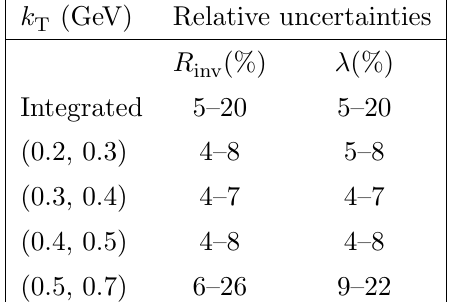
Table 1 . Total systematic uncertainties in di(cid:11)erent k technique. The ranges in the uncertainties indicate the minimum and maximum values found for all multiplicity